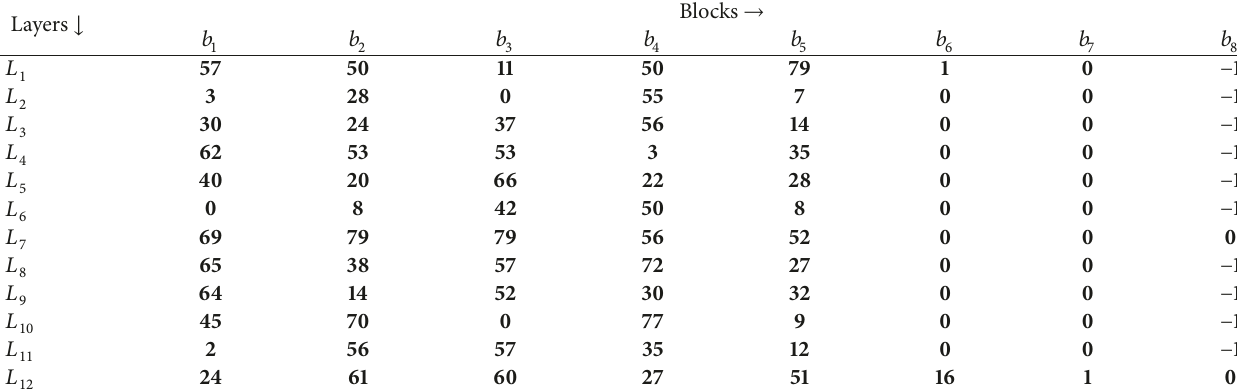
Table 5: Block shift matrix 𝛽 S showing the right-shift values for the valid blocks to be